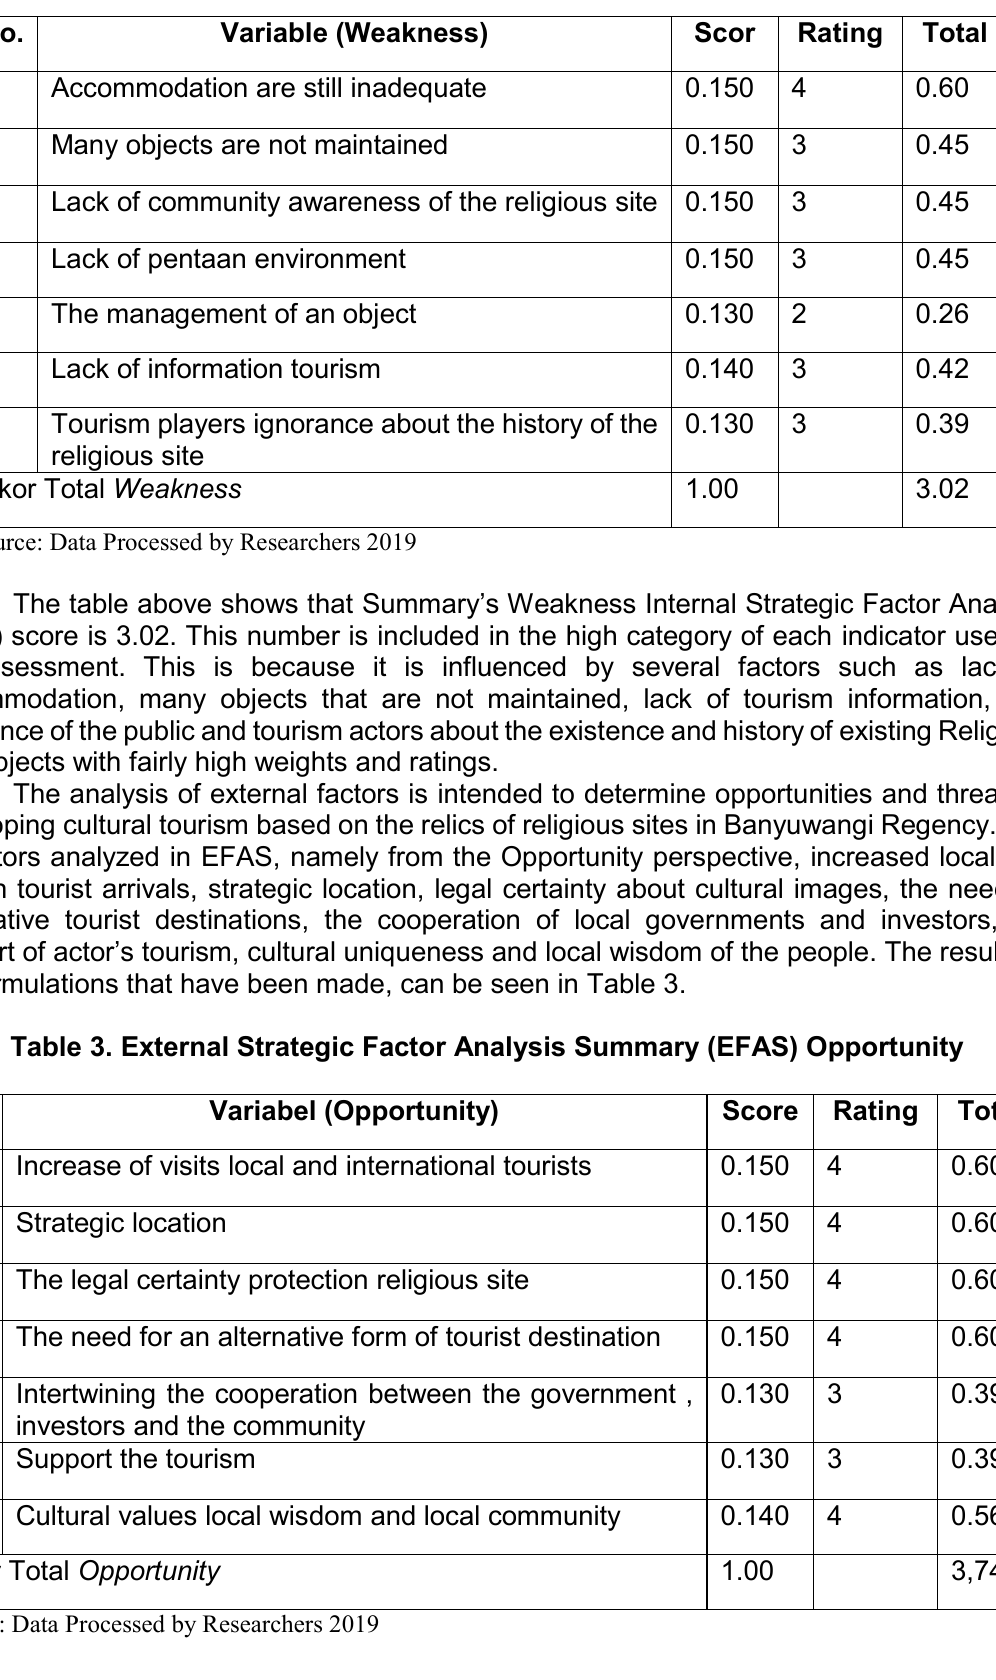
Table 2. Summary of Internal Strategic Factor Analysis (IFAS) of Weakness